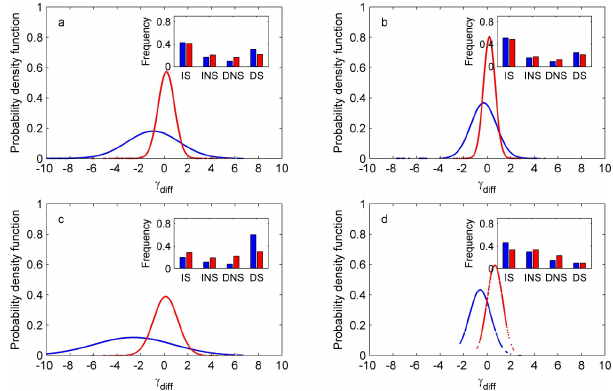
Figure 9. Probability density function for the differences of moving climate sensitivities of barley yield to mean growing-season temper- ature (blue line) and total growing-season water availability index (red line) between 1995–2008 and 1982–1995 for Europe (a) , and climate zones Cf (b) , Cs (c) , and Df (d) . The inset figure shows the percentages of pixels suffering the four different trend types (signifi- cantly increasing, IS; increasing but not significant, INS; decreasing but not significant, DNS; significantly decreasing, DS) for climate sensitivities of barley yield to mean growing-season temperature (blue bars) and total growing-season water availability index (red